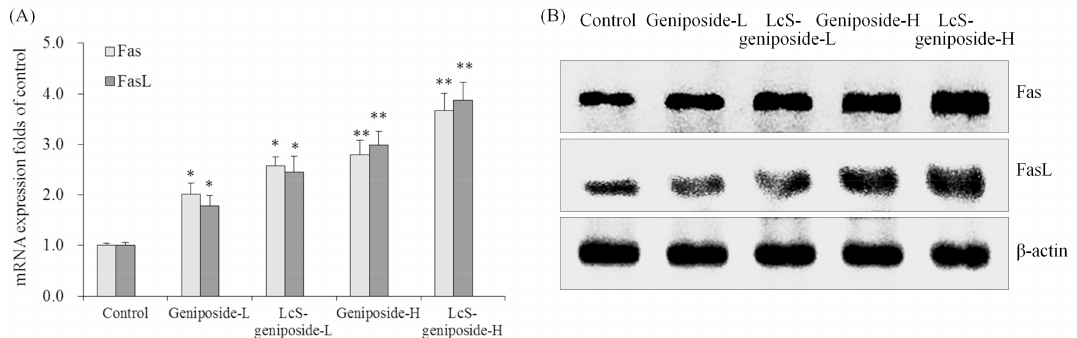
carcinoma HSC-3 cells. * p < 0.05, ** p < 0.01 vs. the control group. Geniposide-L: 25 µ g/mL geniposide; LcS-geniposide-L: 1.0 × 10 6 CFU/mL LcS + 25 µ g/mL geniposide; Geniposide-H: 50 µ g/mL geniposide; LcS-geniposide-H: 1.0 × 10 6 CFU/mL LcS + 50 µ g/mL geniposide. 2.9. mRNA and Protein Expressions of TIMP-1, TIMP-2, MMP-2 and MMP-9 in HSC-3 Cells Geniposide-treated HSC-3 cells hadhigher TIMP-1 and TIMP-2 mRNA and protein expressions